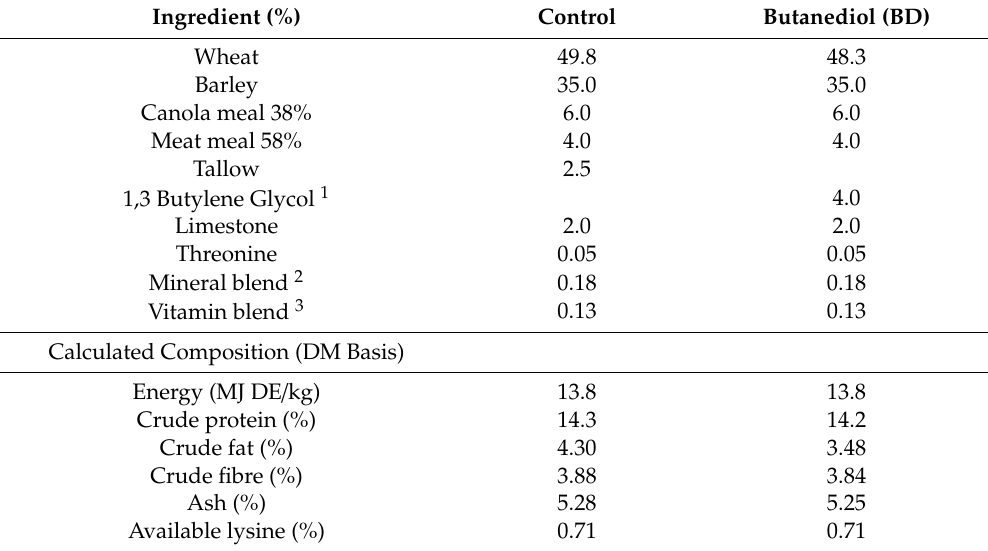
Table 1. Composition of late gestation